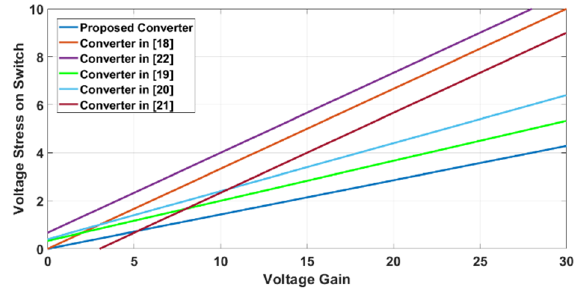
Figure 7. The voltage stress on the switch of various converters.